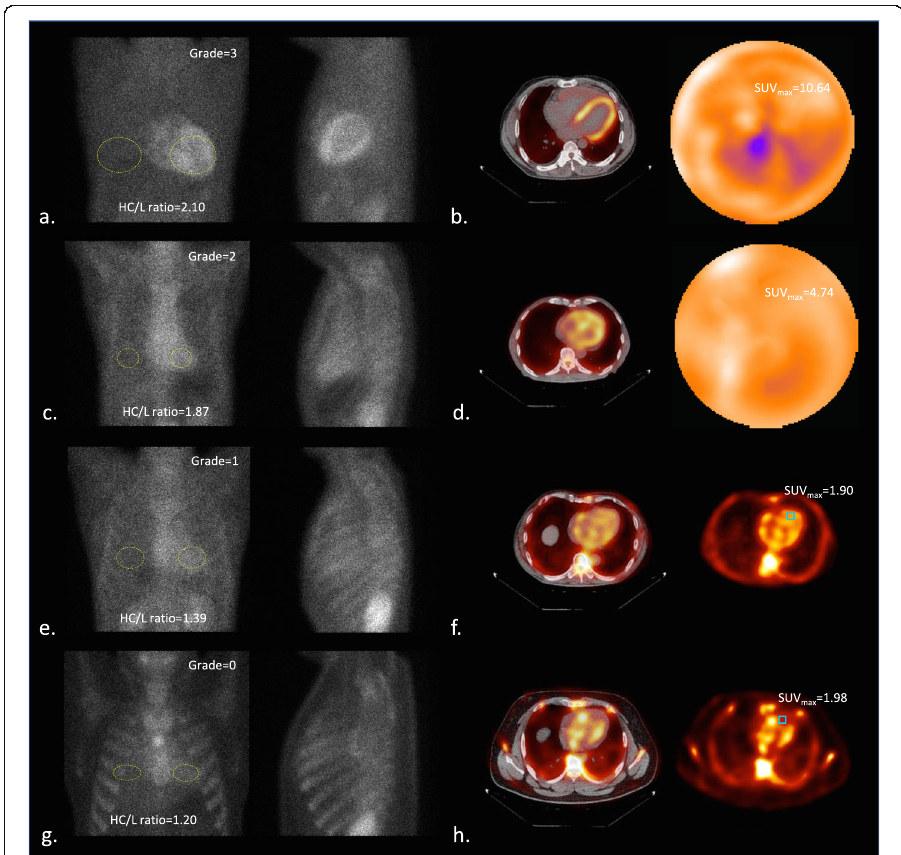
Fig. 4 Representative images of 99m Tc-PYP planar and quantitative SPECT. a Grade = 3 in Perugini visual scores with H/CL ratio = 2.10 and SUV max = 10.64 g/ml in b . c Grade = 2 with H/CL ratio = 1.87 and SUV max = 4.74 g/ml in d . e Grade = 1 with H/CL ratio = 1.39 and SUV max = 1.90 g/ml in f . e Grade = 0 with H/CL ratio = 1.20 and SUV max = 1.98 g/ml in